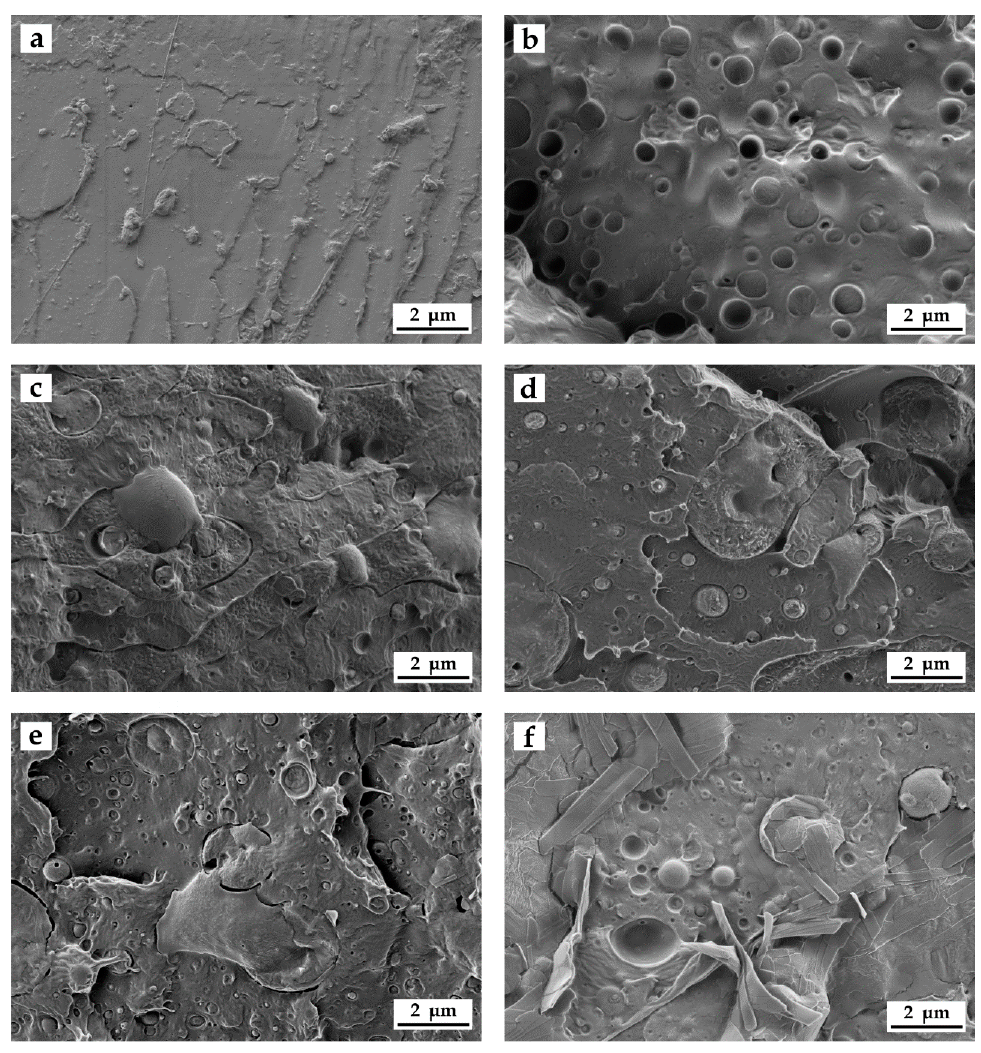
Figure 4. Field emission scanning electron microscopy (FESEM) images of the fracture surfaces of the polylactide (PLA), poly( ε -caprolactone) (PCL), and thermoplastic starch (TPS) blend pieces: ( a ) Neat PLA; ( b ) PLA 60 PCL 40 TPS 0 ; ( c ) PLA 60 PCL 30 TPS 10 ; ( d ) PLA 60 PCL 20 TPS 20 ; ( e ) PLA 60 PCL 10 TPS 30 ; and ( f ) PLA 60 PCL 0 TPS 40 . Images were taken at 5000× and scale markers are of 2 µm.